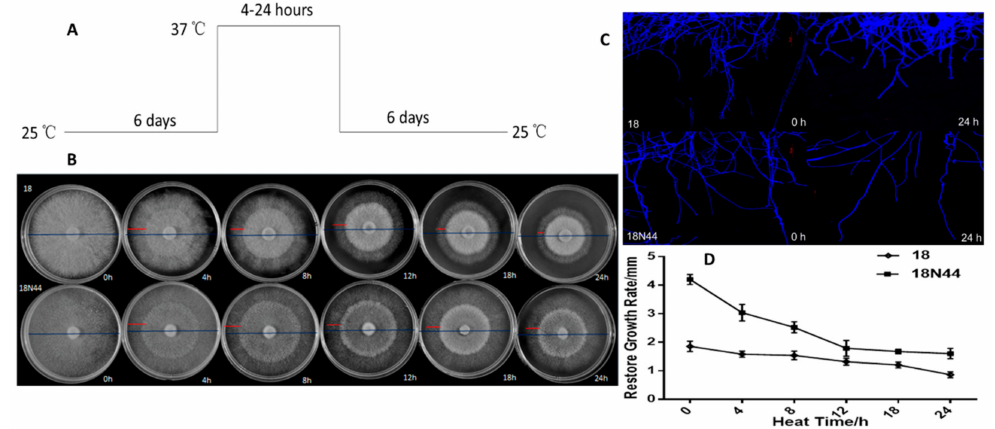
Figure 1. Heat stress inhibited the growth of Lentinula edodes mycelia. ( A ) Two strains of L. edodes were cultured on PDA plates for 6 d and then exposed to 37 ◦ C for 0 to 24 h followed by 6 days at 25 ◦ C. ( B ) The morphology of mycelial growth for the entire 13 days (blue line) and the following 6 days at 25 ◦ C (after heat stress) (red line) is shown. ( C ) Microscopically, the mycelial morphology changed after 24 h of heat stress. Vegetative hyphae were removed from actively growing colonies, suspended in Fluorescent Brightener 28, and detected under a microscope. ( D ) Recovery of the mycelial growth rate of L. edodes after heat stress. The values are the means ± SD of three independent